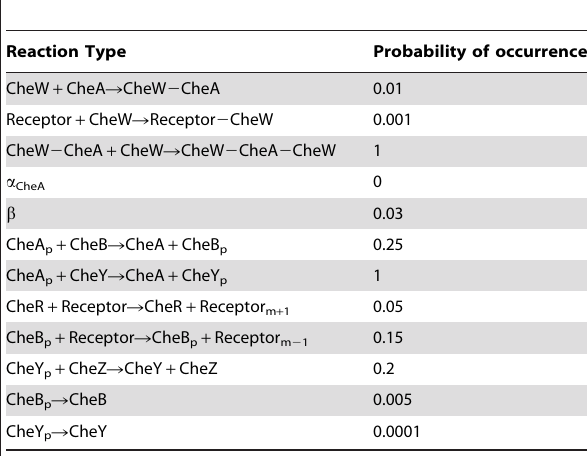
Table 1. Reactions and corresponding probabilities implemented in